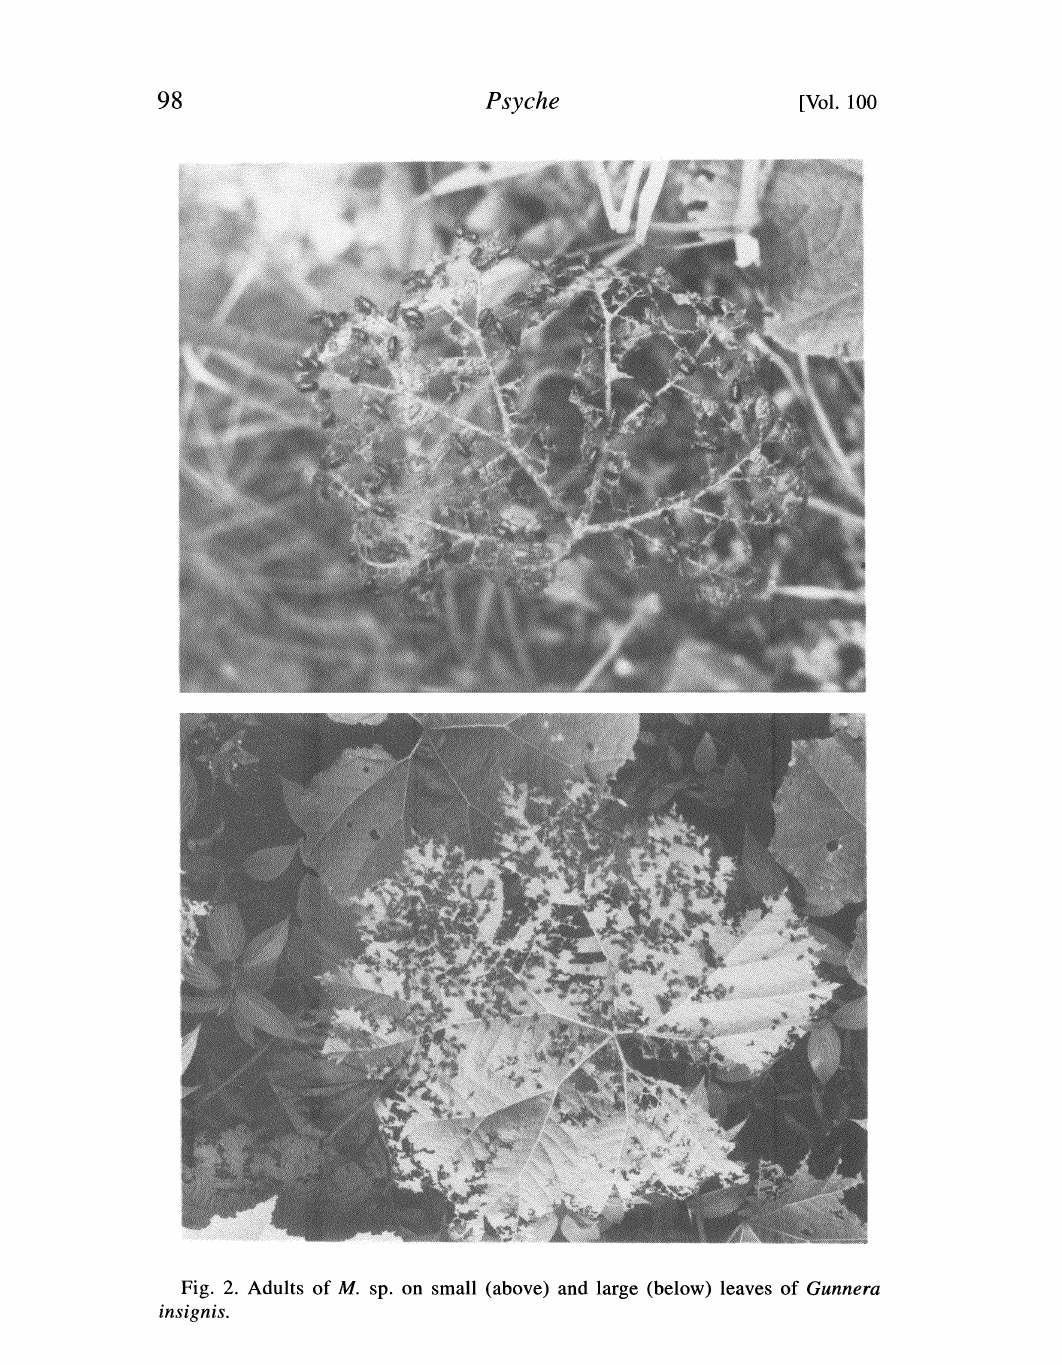
Fig. 2. Adults of M. sp. on small (above) and large (below) leaves of Gunnera